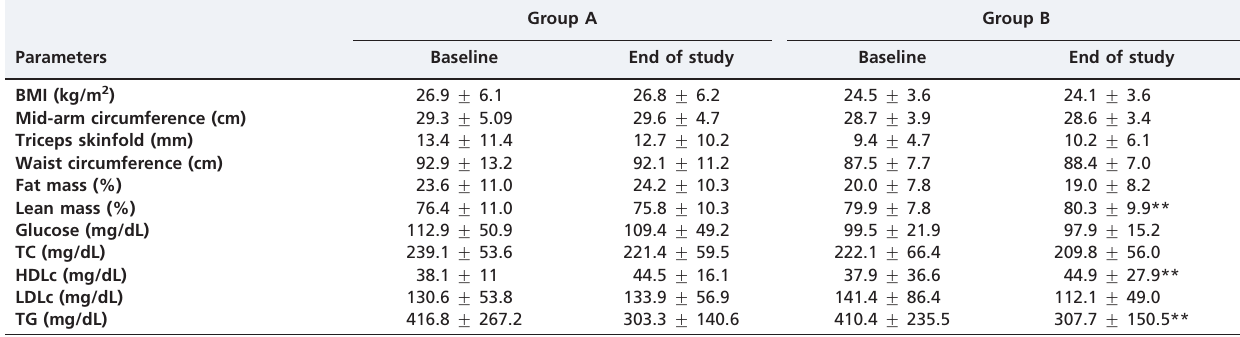
Table 1 - Anthropometric and biochemical parameters of HIV-positive subjects with lipodystrophy.